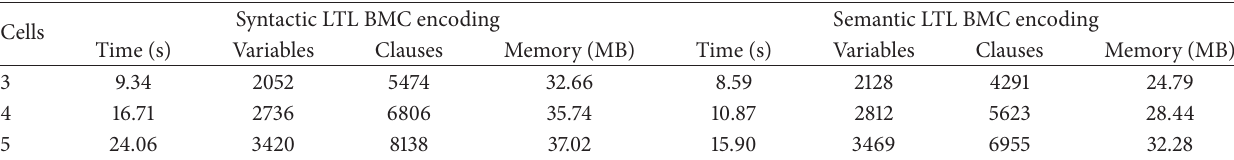
Table 5: Comparison of syntactic/semantic LTL BMC with liveness